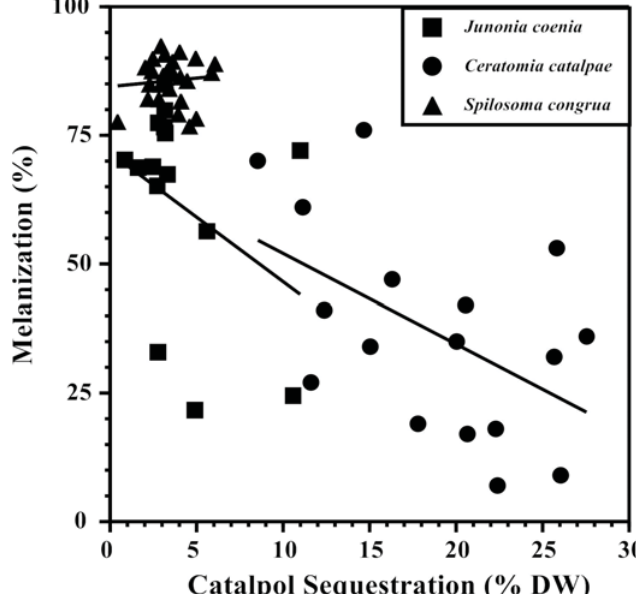
Figure 2. Tradeoffs between defensive chemistry and immune response of three Lepidopteran herbivores support the “vulnerable host hypothesis” [90]. Catalpol sequestration is negatively correlated with melanization ability of the specialists Junonia coenia (Nymphalidae) and Ceratomia catalpae (Sphingidae), but not the generalist Spilosoma congrua